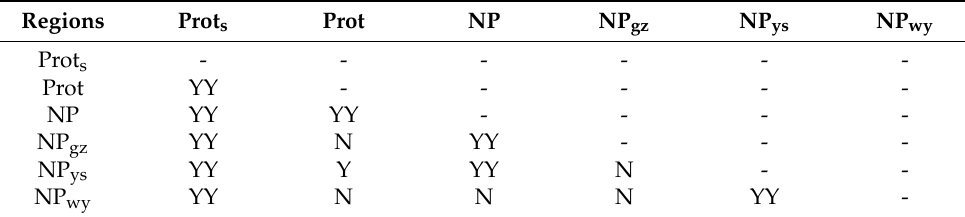
Figure 5. The percentage of changed area between 1986 and 2020. Prot s : Wuyishan Nature Reserve; Prot: non-nature reserve within Wuyishan National Park; NP: non-protected area; NP gz : non- protected area in Guangze County; NP ys : non-protected area in Yanshan County; NP wy : non- protected area in Wuyishan City. Table 4. Significance test of the abrupt change area among different regions during